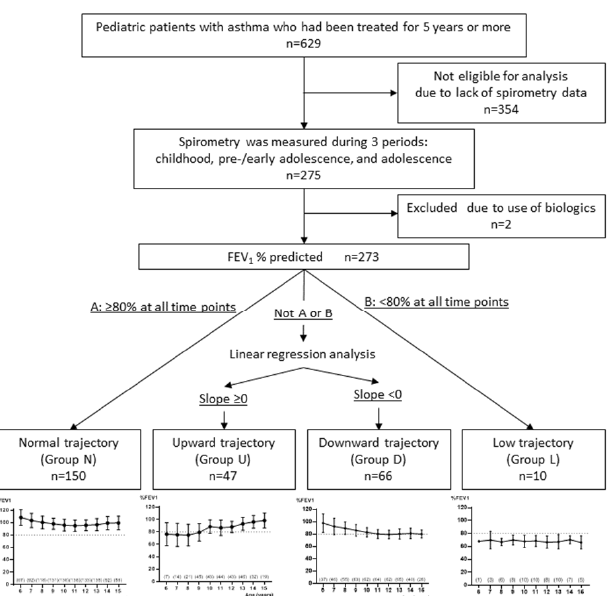
Figure 1. Flow of the subjects and classification of lung function trajectories in the retrospective study. Numbers in parenthesis indicate the number of patients at each age.